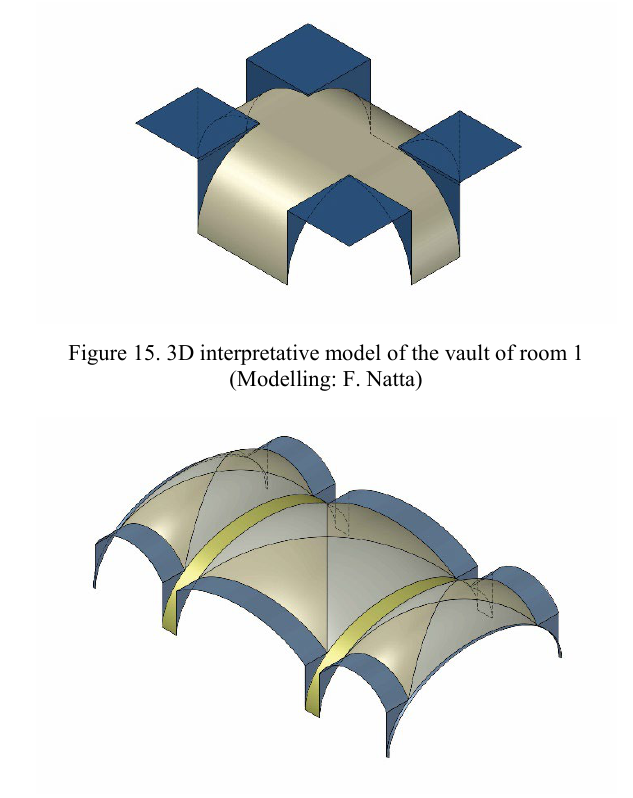
Figure 16. 3D interpretative model of the vault of ‘Prima Anticamera’, room 2 (Modelling: F. Natta)